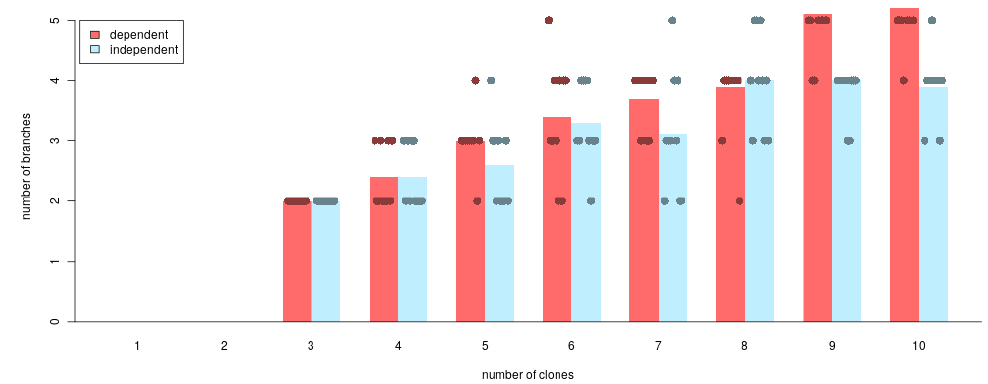
Figure A7. Average number of branches considering different numbers of clones; red: depen- dent branches at simulated branched dependent evolution, and blue: independent branches at simulated branched independent evolution. Red and blue dots indicate the precise number of branches, respectively.